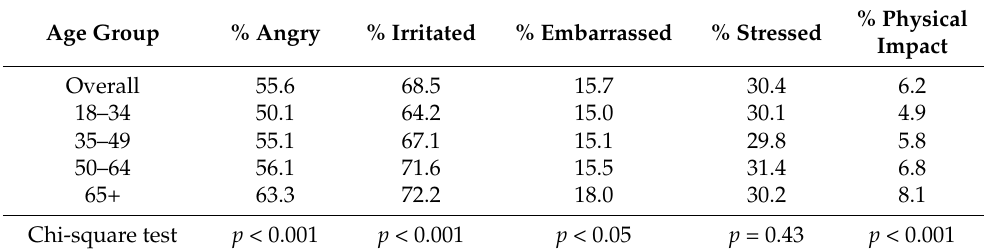
Table 6. Percentage of non-financial impact in weighted sample.